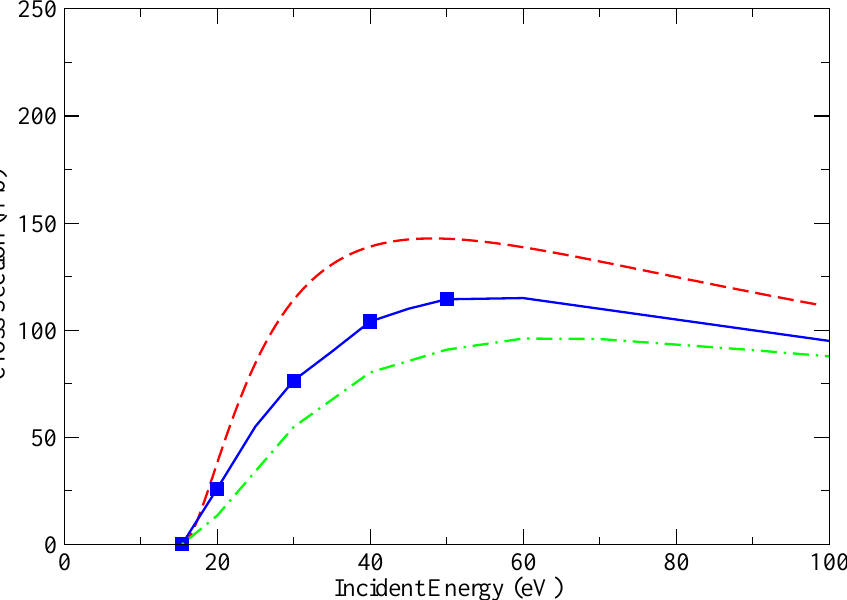
Figure 7. Electron-impact direct ionization of the 6 s subshell of Pb. Dashed line (red): distorted-wave method with a polarization potential, solid line with squares (blue): time-dependent close-coupling method with a polarization potential, dot–dash line (green): convergent close-coupling method [9] with a polarization potential (1.0 Mb = 1.0 × 10 − 18 cm 2